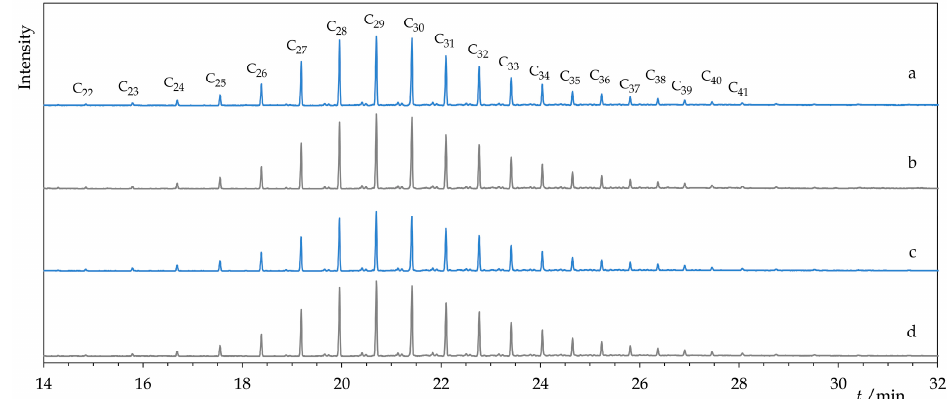
Figure 2. Comparison of chromatograms of Permulgin 3274 ( a ), hydrogenated Permulgin 3274 ( b ), UV aged Permulgin 3274 ( c ) and UV aged hydrogenated Permulgin 3274 ( d ). C x : n -alkanes with a chain length of x carbon atoms.